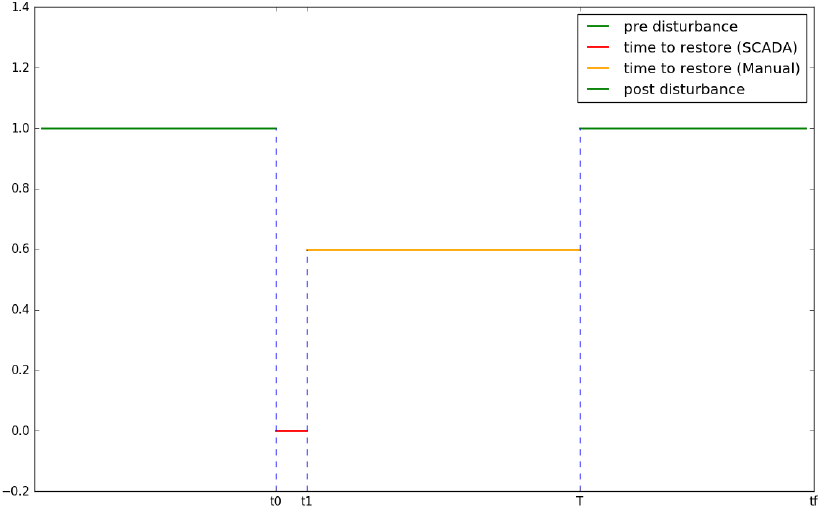
Figure 3. The QoS behavior of a medium-voltage (MV)